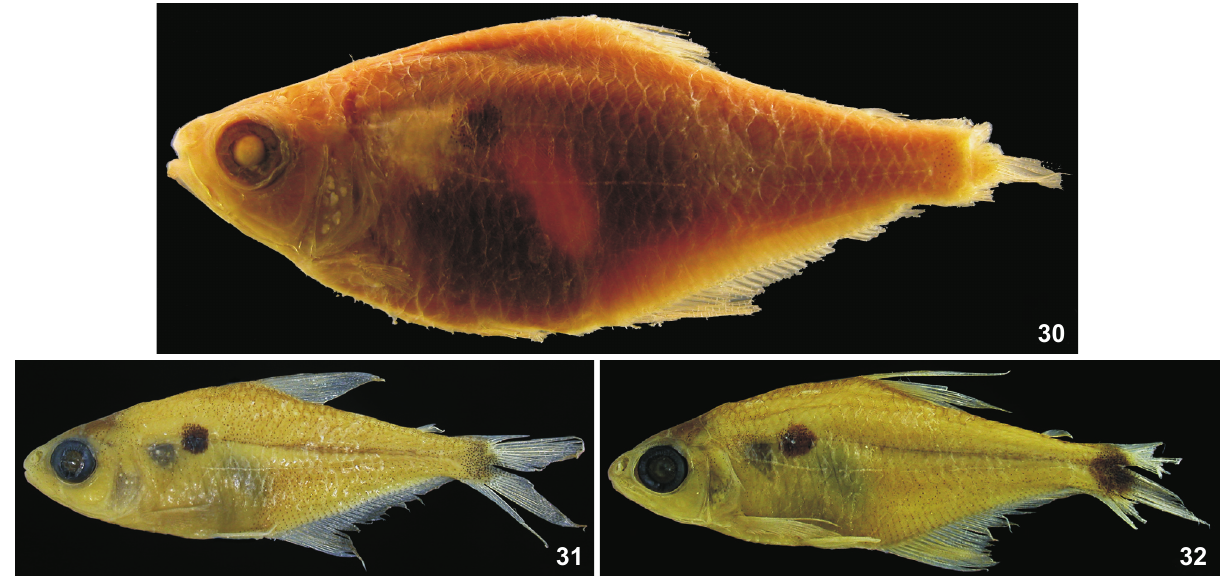
Figuras 30-32 Phenacogaster franciscoensis : (30) FMNH 54599, holótipo, 30,2 mm CP, Boqueirão, sistema do Rio São Francisco, Minas Gerais; (31) MCP 27816, fêmea, 27,5 mm CP, Rio Pirapitinga, sistema do Rio São Francisco, Minas Gerais; (32) MCP 32531, macho, 28,7 mm CP, Rio Juramento, sistema do Rio São Francisco, Minas Gerais. Comparar a forma da nadadeira anal de macho e